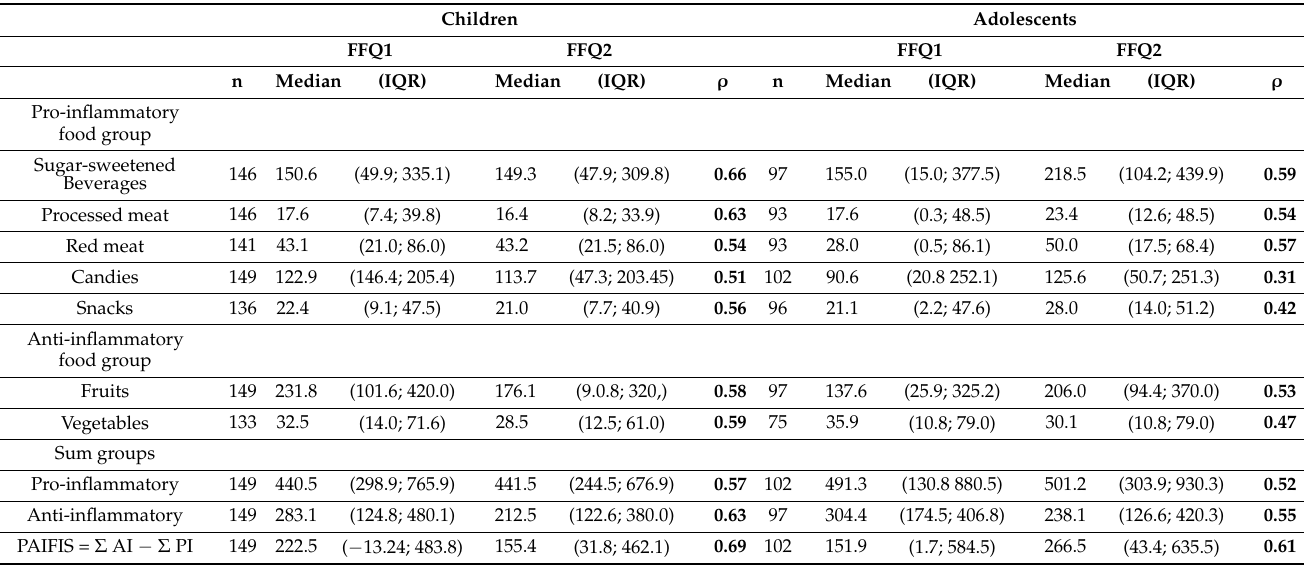
Table 3. Reliability of the PAIFIS in grams per day in a sub-sample of the SAYCARE Study.